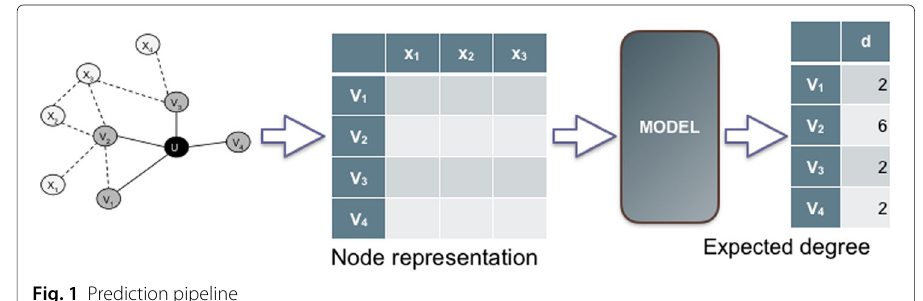
Fig. 1 Prediction